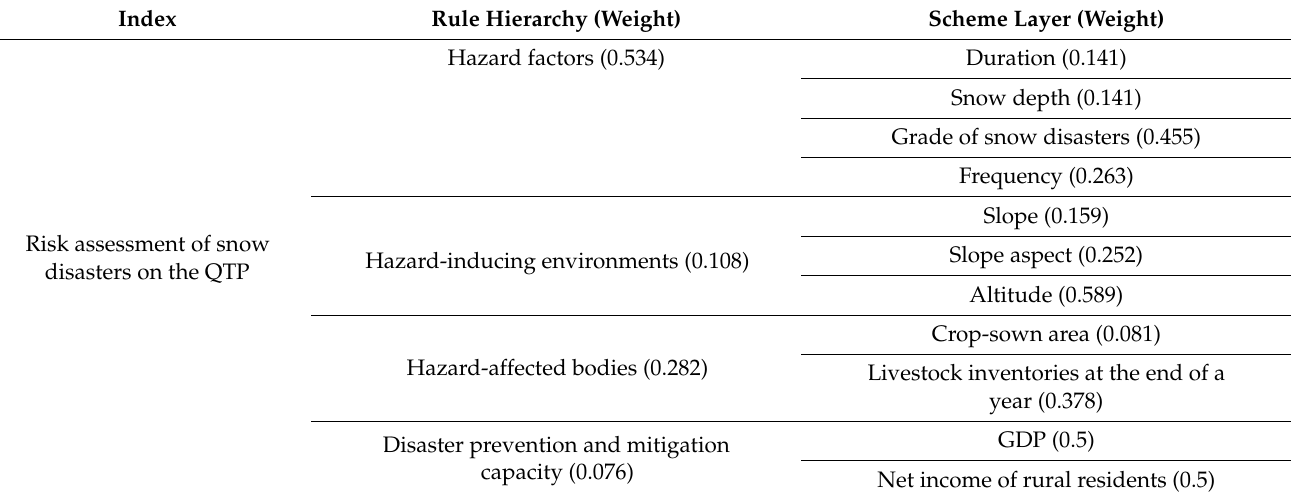
Table 3. Risk assessment indices for snow disasters on the QTP and their